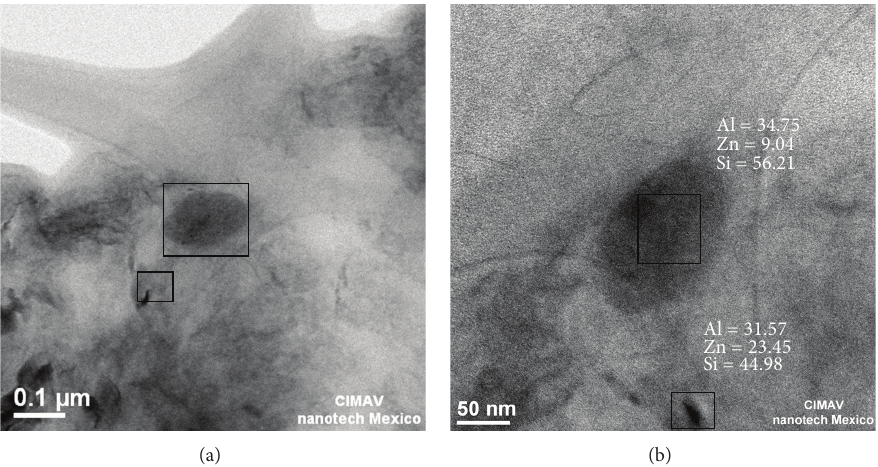
Figure 3: ((a) and (b)) Bright field high-resolution TEM images and EDXS results (wt%) of Al-Zn-1.2Si nanocomposites.